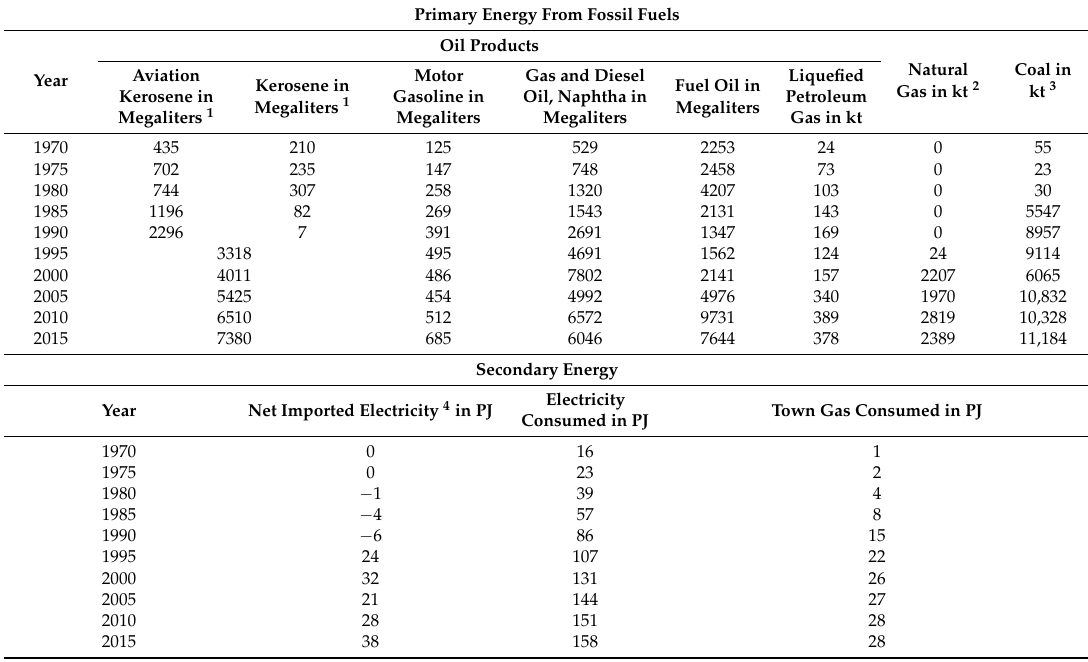
Table 3. Consumption of energy (primary and secondary) in Hong Kong from 1970 to